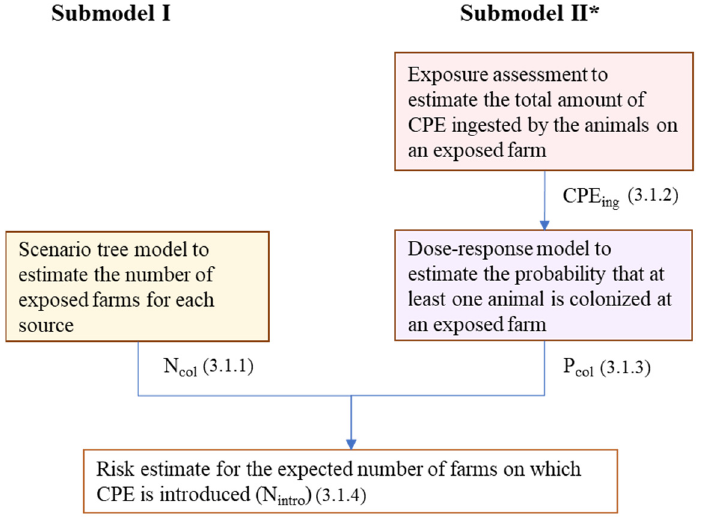
Figure 4. Outline of the risk model to estimate the introduction risk of CPE into Dutch livestock farms from five sources: imported livestock, livestock feed, companion animals (cats and dogs), hospital patients, and returning travelers. * Submodel II is not used for imported livestock because the introduction of a colonized animal into a livestock farm automatically results in colonization of the farm.